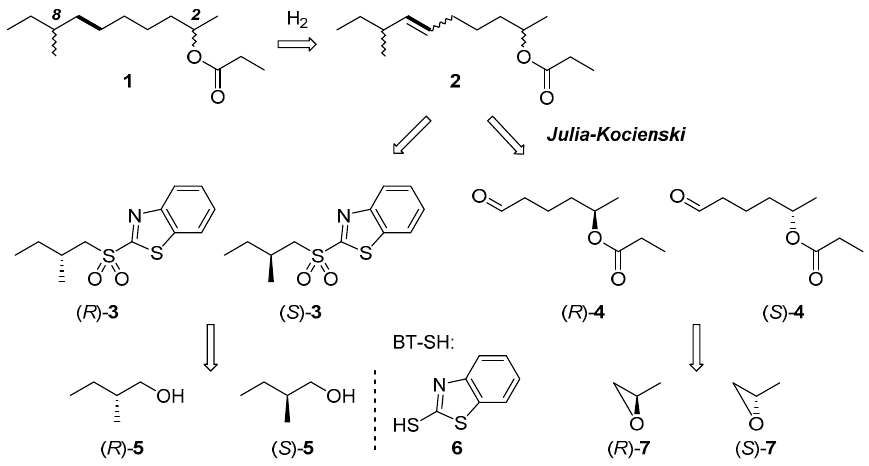
Figure 2. Retrosynthetic analysis of 1 based on Julia–Kocienski olefination.